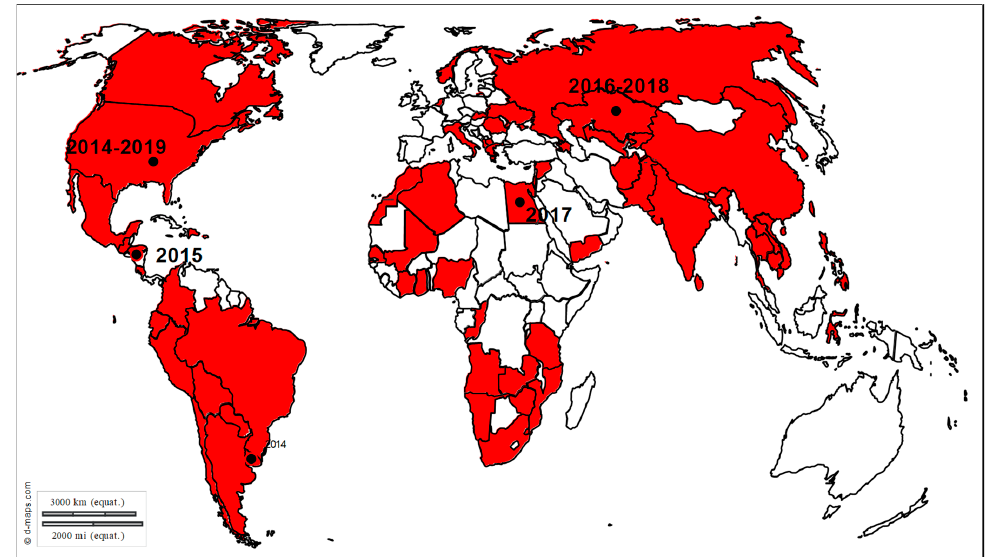
Figure 5. Distribution of rabies outbreaks. Recent outbreaks in horses reported to the OIE WAHIS interface [15], Promed Alerts [16] or in the scientific literature are depicted by dots